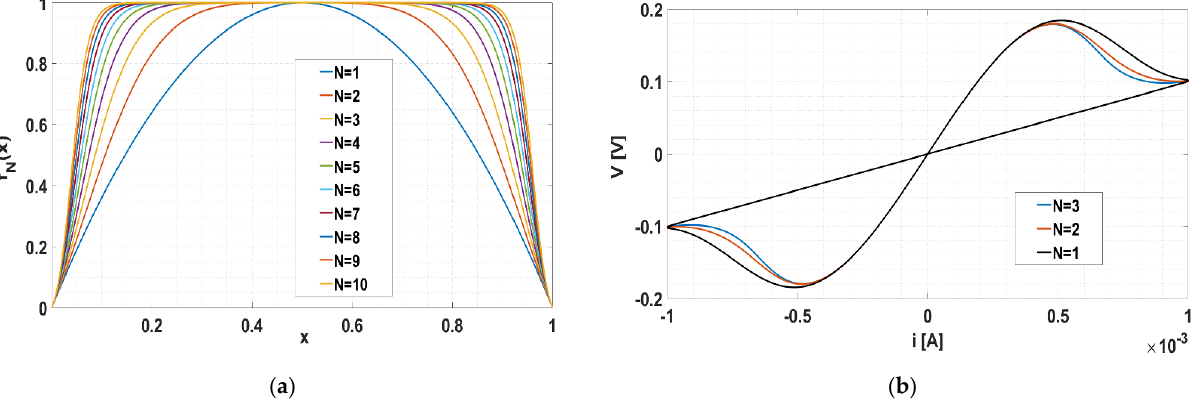
Figure 1. ( a ) Proposed novel window function in the used model of memristor; ( b ) Current–voltage characteristics of model with novel window function for N = 1, 2 and 3. Simulation parameters: i ( t ) = Im cos ( ω t) , Im = 1 mA, ω = 2 π rad/s, R OFF = 1 k Ω , R ON = 100 Ω , k =10 4 C − 1 .